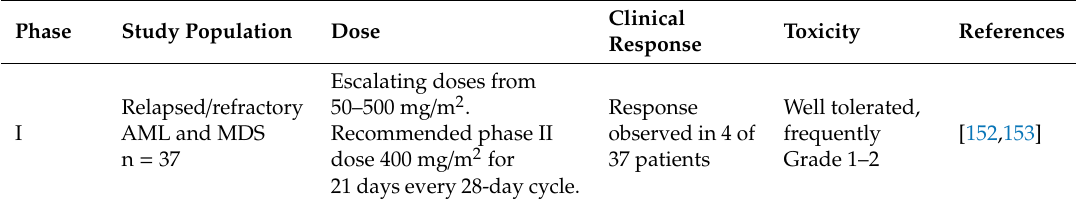
Table 5. Summary of a clinical trial of FF-10501.